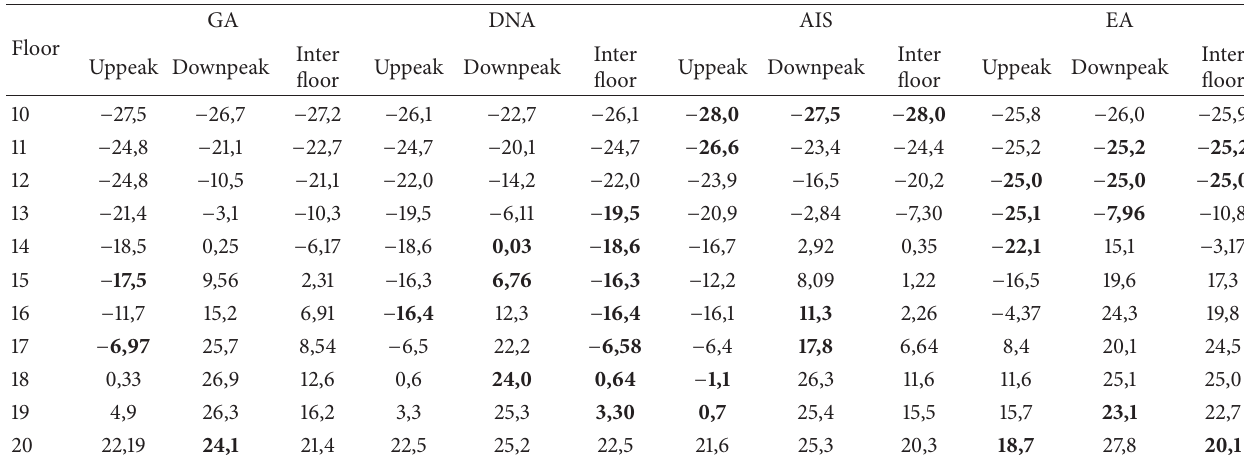
Table 5: The results obtained from the fuzzy